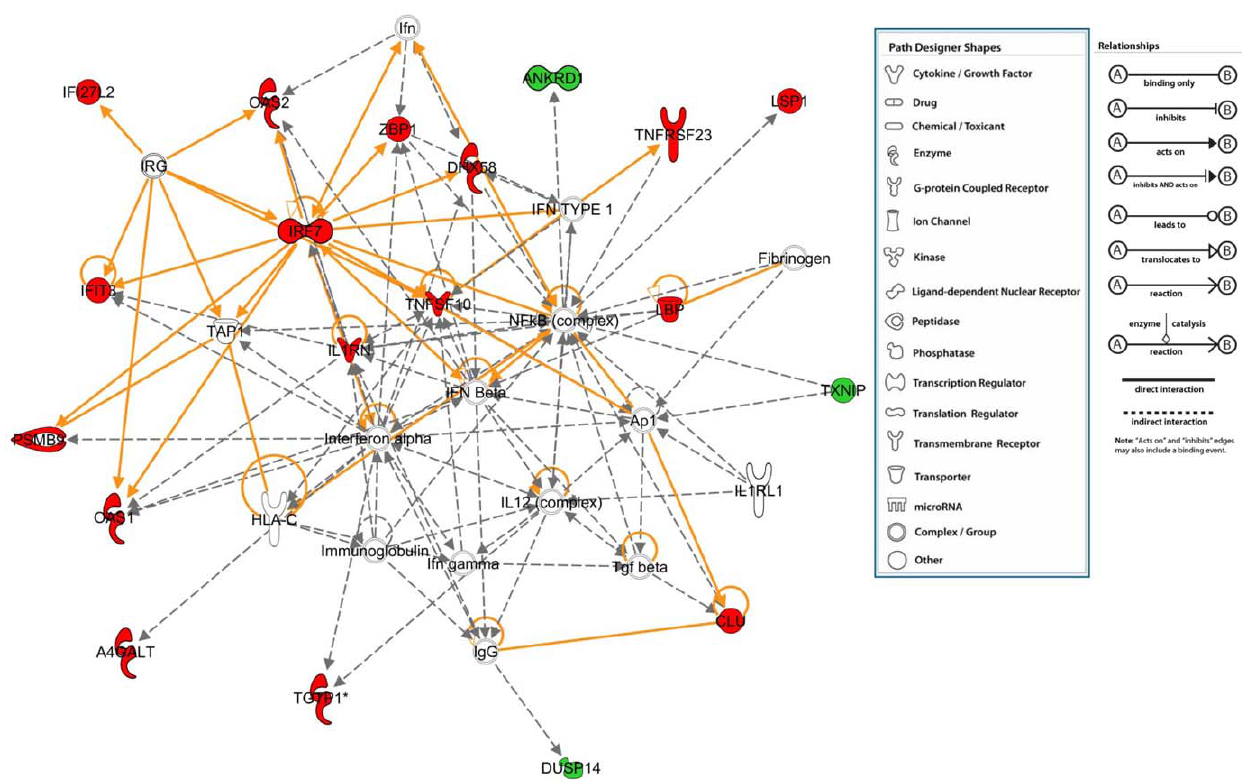
Figure 9. Gene network analysis shows that the genes regulated by Mta1 in the presence of P53 are involved in the networks associated with antimicrobial and inflammatory responses (statistically most significant network). When compared with the wild type MEFs, the genes that were up regulated in Mta1 knockout MEFs are shown in red and the down regulated genes are shown in green. The network with the highest score from the IPA analysis was considered to be the most significant network and majority of the genes that were found in this network were up-regulated.